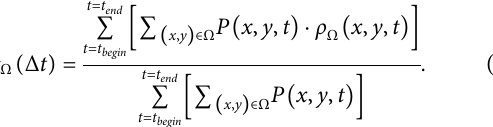
Frontiers in Physics |